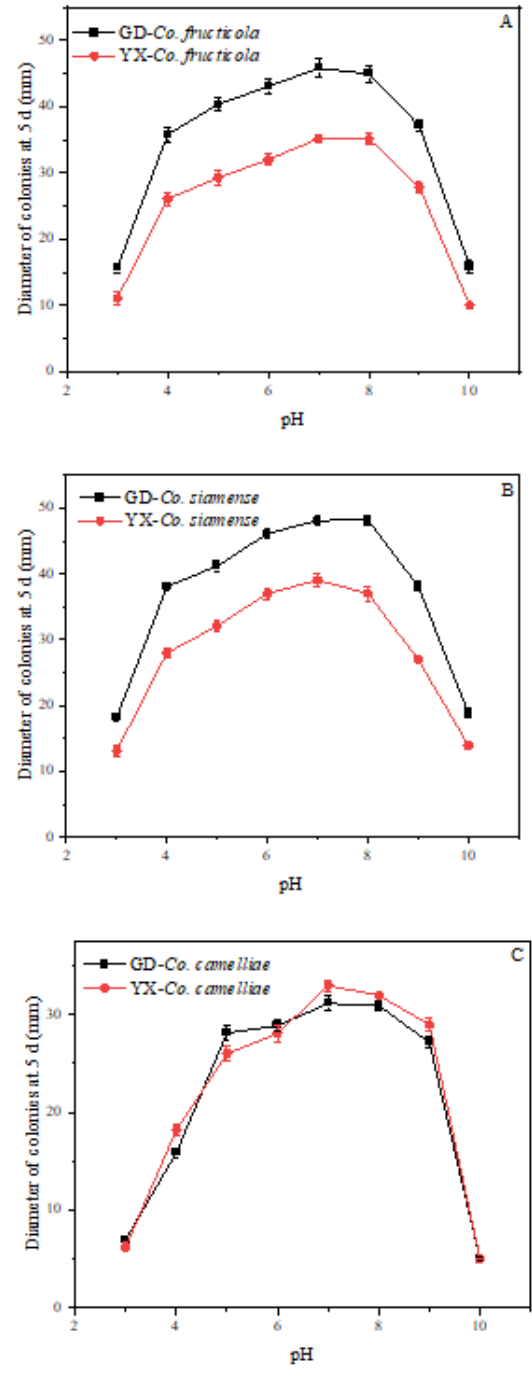
Figure 7. Effect of pH on the mycelial growth of ( A ) YX- Co . fructicola (YX2-5-2) and GD- Co . fructicola ; ( B ) YX- Co . siamense (2YX-8-1-1) and GD- Co . siamense ; ( C ) YX- Co . camelliae (2YX-5-1) and GD- Co . camelliae . The error bars represent standard deviations based on three biological